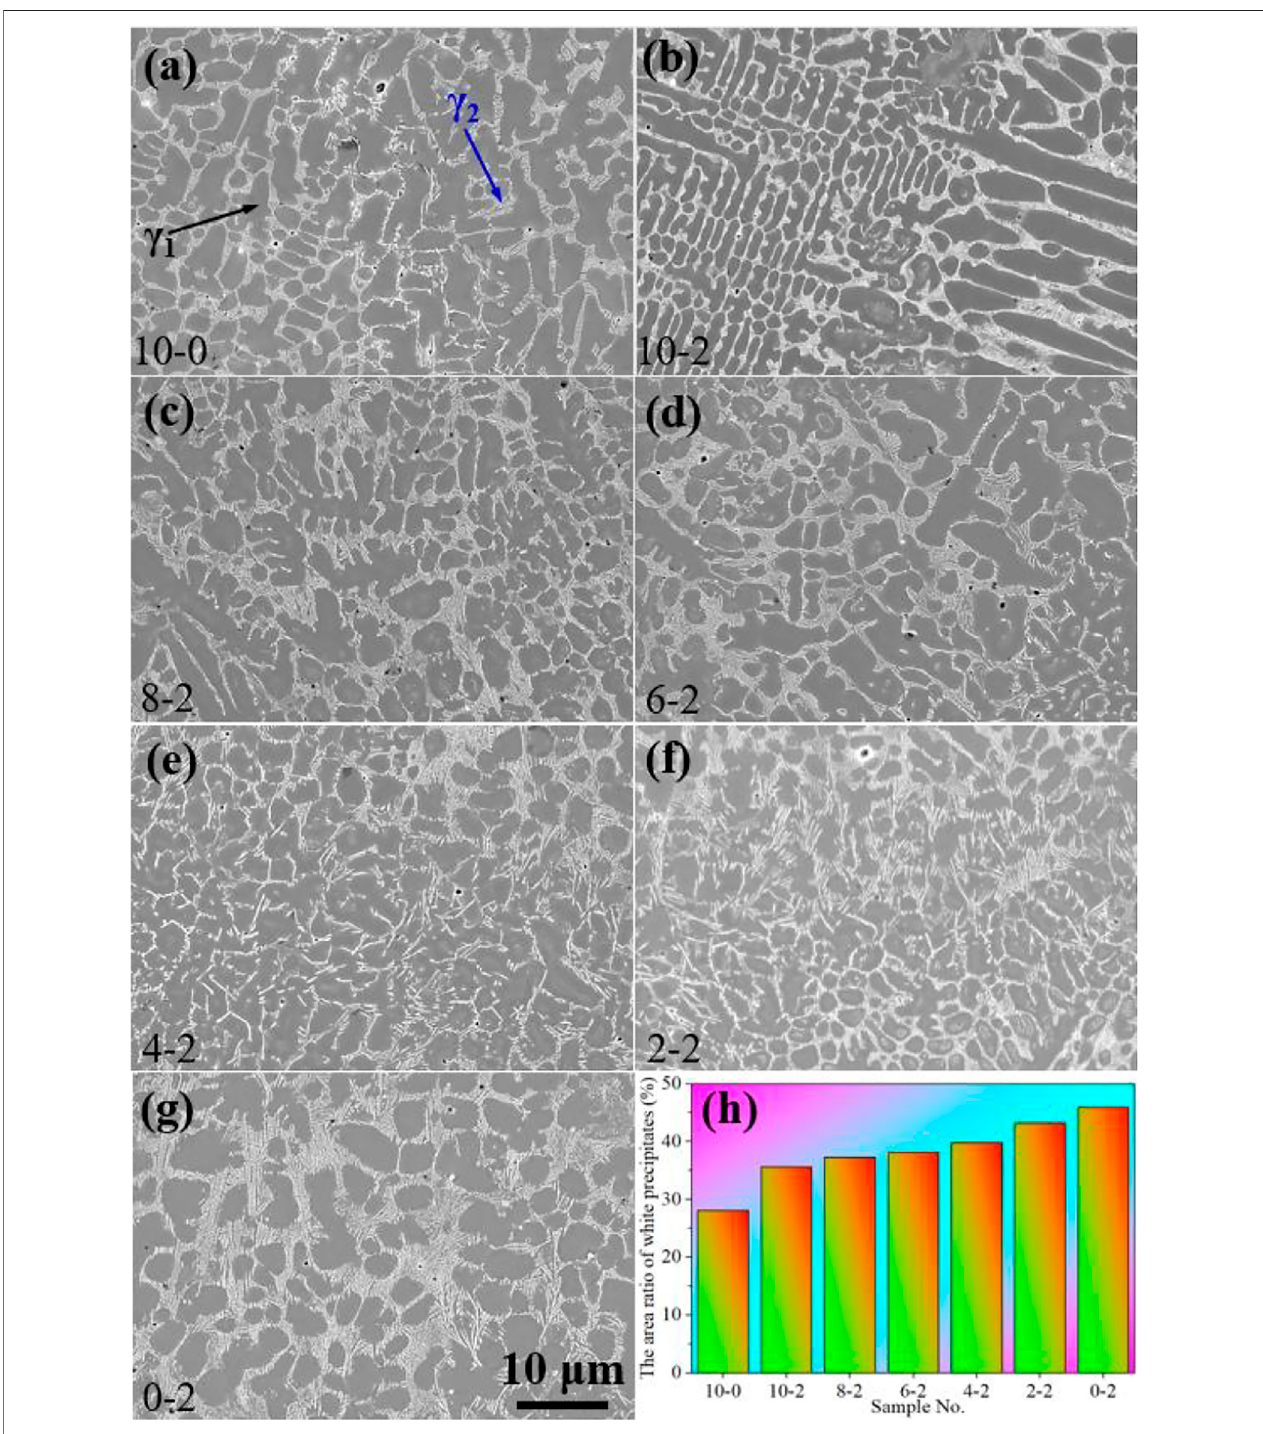
FIGURE 4 | SEM image of different samples in the building direction. (A) 10 – 0; (B) 10 – 2; (C) 8 – 2; (D) 6 – 2; (E) 4 – 2; (F) 2 – 2; (G) 0 – 2; and (H) the area ratio of white precipitates.